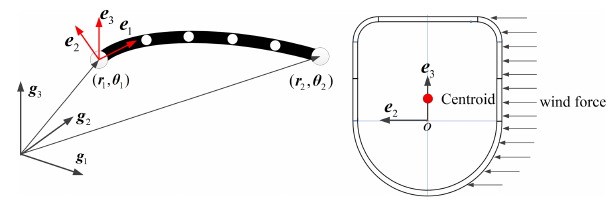
Figure 3. A local coordinate system of